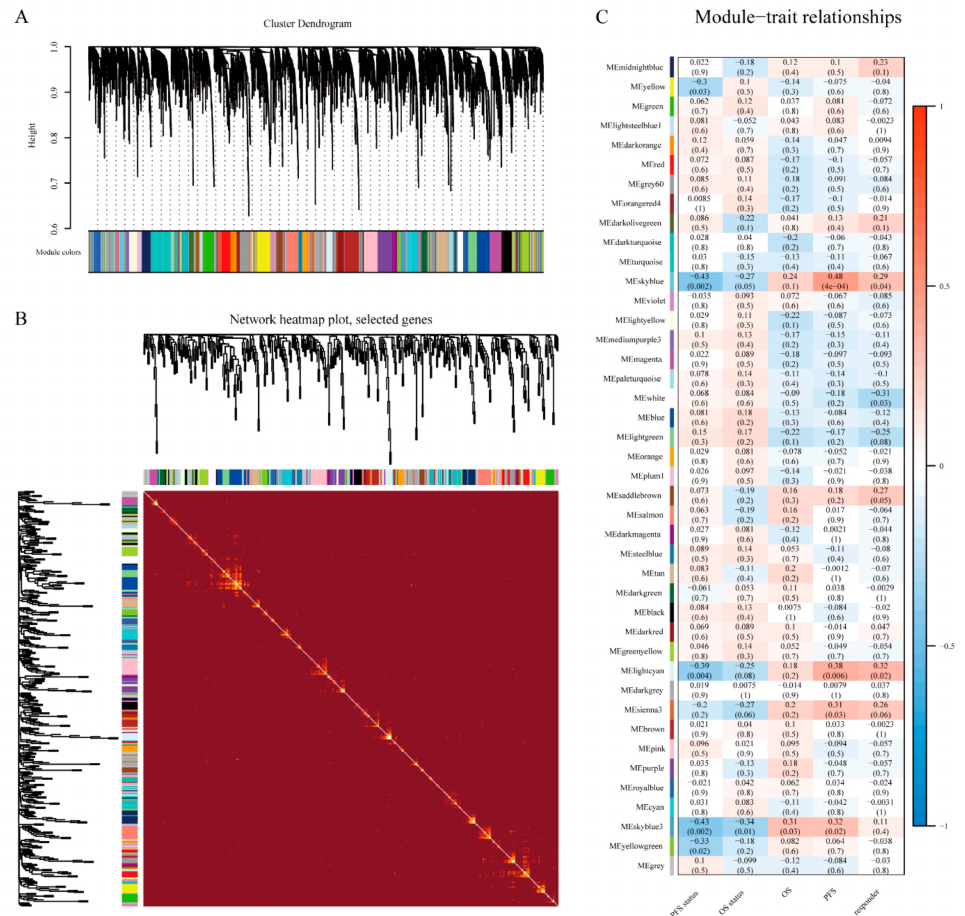
Figure 3. Identification of key module related to survival benefit (progression-free survival (PFS) and overall survival (OS)) by WGCNA. ( A ) Clustering dendrogram of long noncoding RNAs (lncRNAs) with dissimilarity based on topological overlap together and assigned module colors. ( B ) The heatmap plot of visualizing all modules. ( C ) The module-trait heatmap plot.